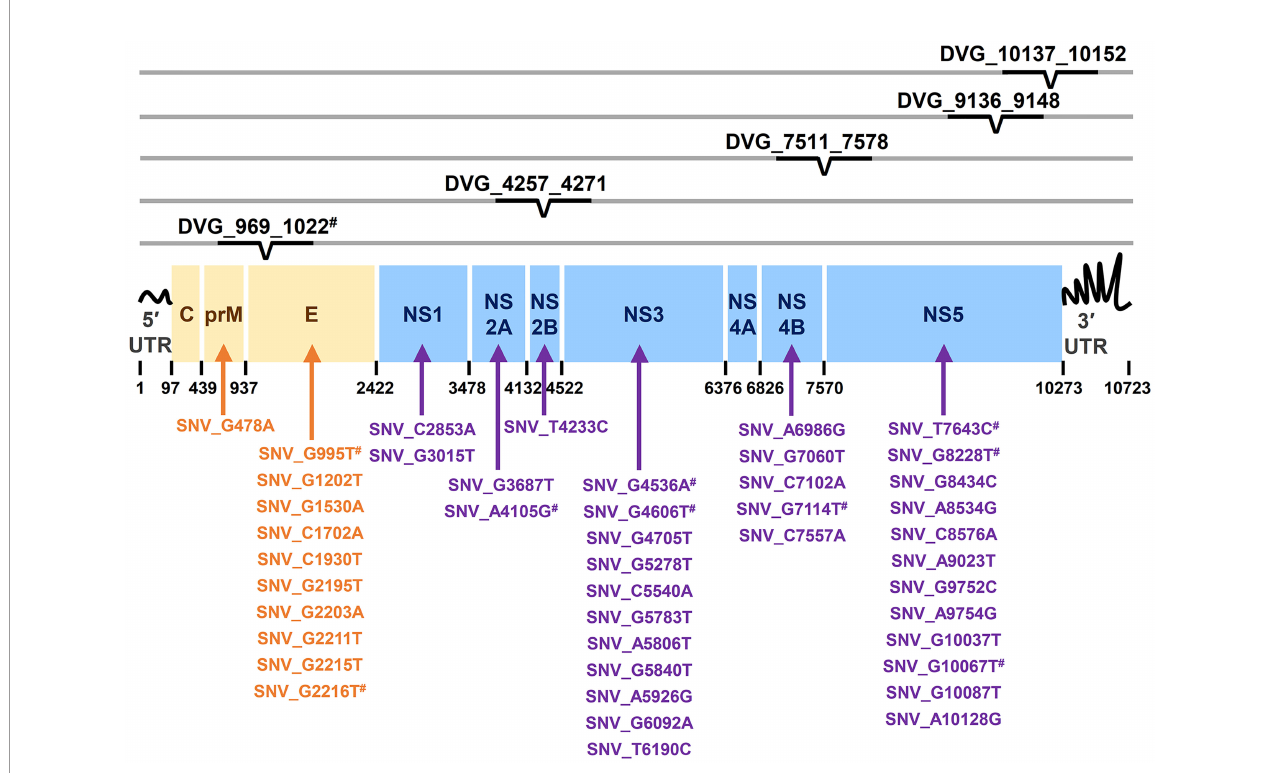
FIGURE 4 | Summary of location distribution of SNVs/DVGs which exhibited high association with dengue disease outcomes in DENV-2 genome. The locations of the nucleotide positions of 44 SNVs and the junction regions of fi ve DVGs that were highly associated with disease severity in DENV-2-infected patients with p < 0.001 are shown in DENV-2 genome. The structural protein (yellow blocks) and non-structural protein (blue blocks) coding regions as well as viral protein coding genes are shown. Arrows indicate the protein coding genes in which the SNVs are located. # indicated the SNVs/DVG which exhibited p < 0.001 in Mann-Whitney U